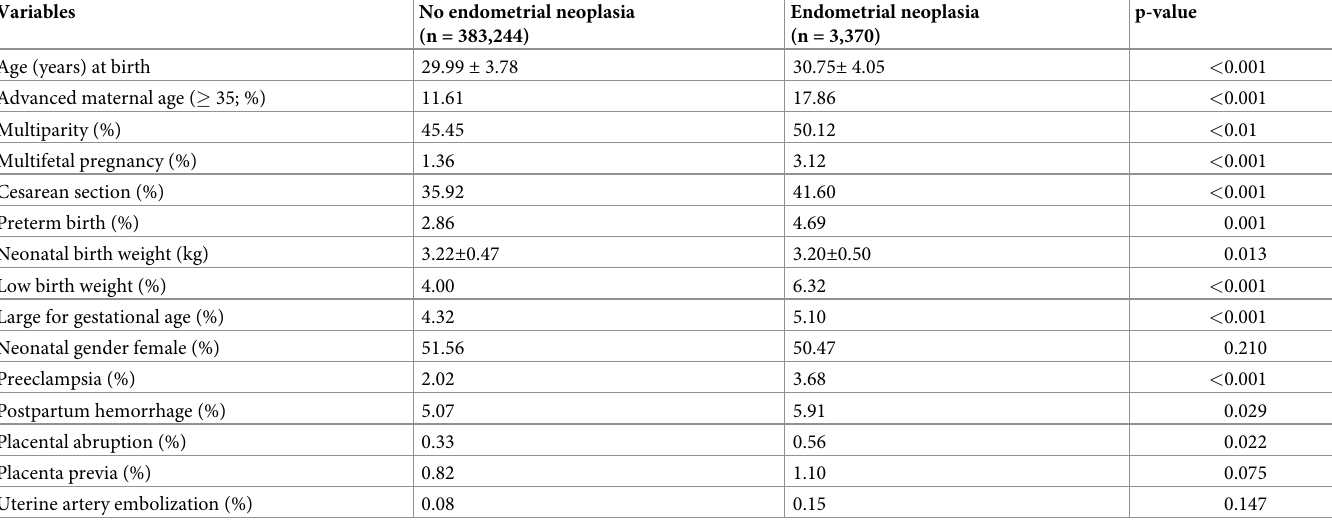
Table 1. Pregnancy characteristics of participants stratified by the development of endometrial neoplasia.